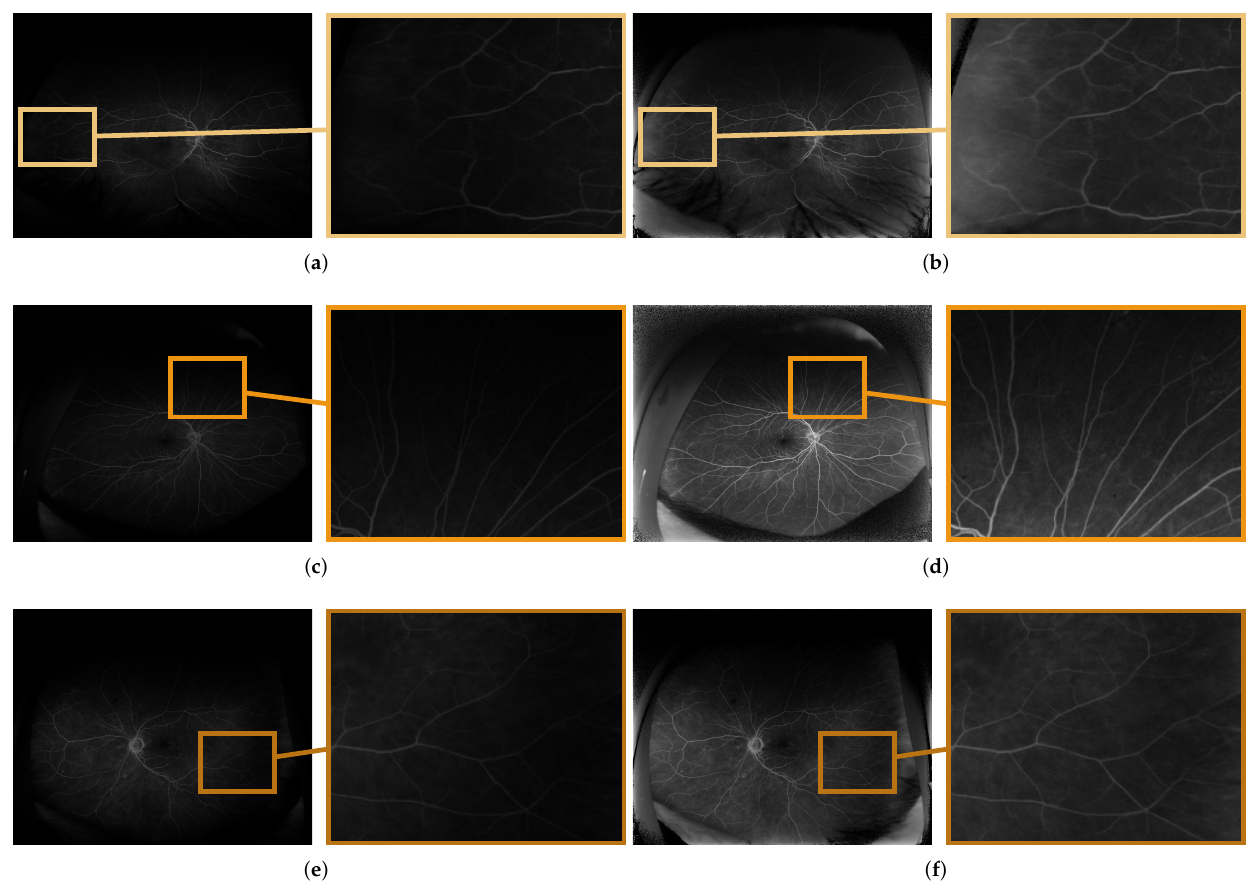
Figure 6. Comparison of exemplary UWFA images: before ( a , c , e ) and after ( b , d , f ) the correction procedure; images taken from the: ( a , b ) early, ( c , d ) mid and ( e , f ) late acquisition phases. Table 2. Quality measure values for selected windows from Figure 6.